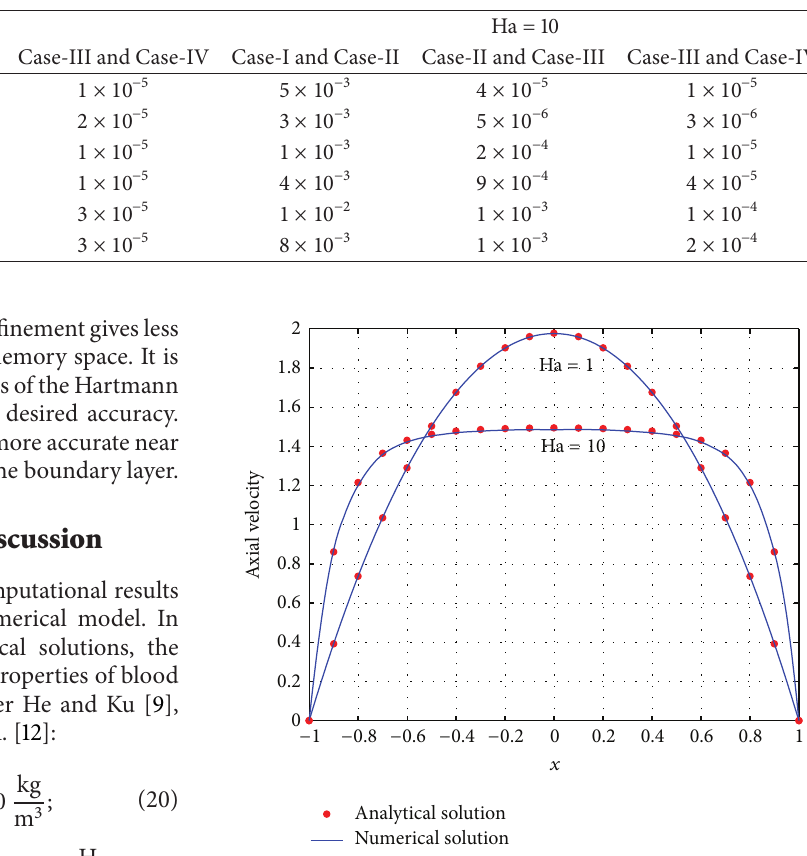
Figure 2: Comparison of axial velocity profile in the developed region with the analytical solutions of Fabri and Siestrunck [26] for Ha = 1 and Ha = 10